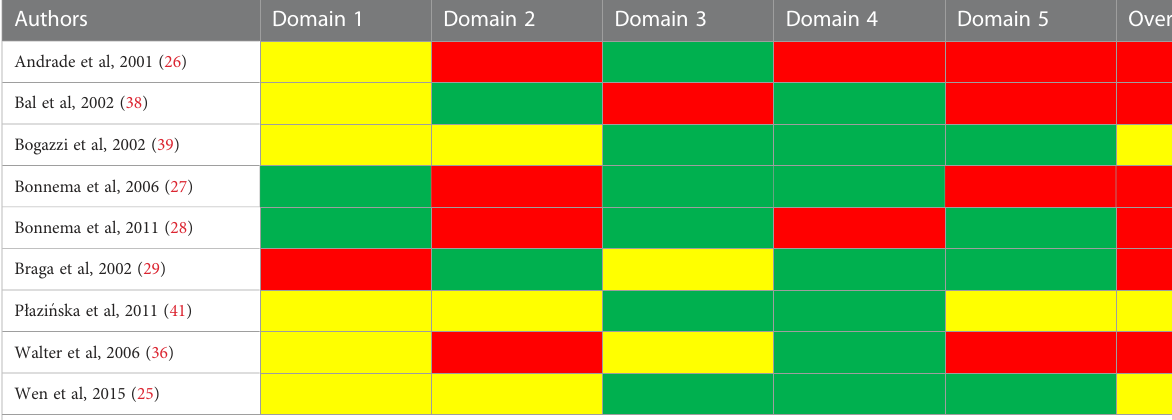
Red indicates high concerns, yellow indicates some concerns and green indicates low concerns. Domain 1: Risk of bias arising from the randomization process. Domain 2: Risk of bias due to deviations from the intended interventions (effect of assignment to intervention). Domain 2: Risk of bias due to deviations from the intended interventions (effect of adhering to